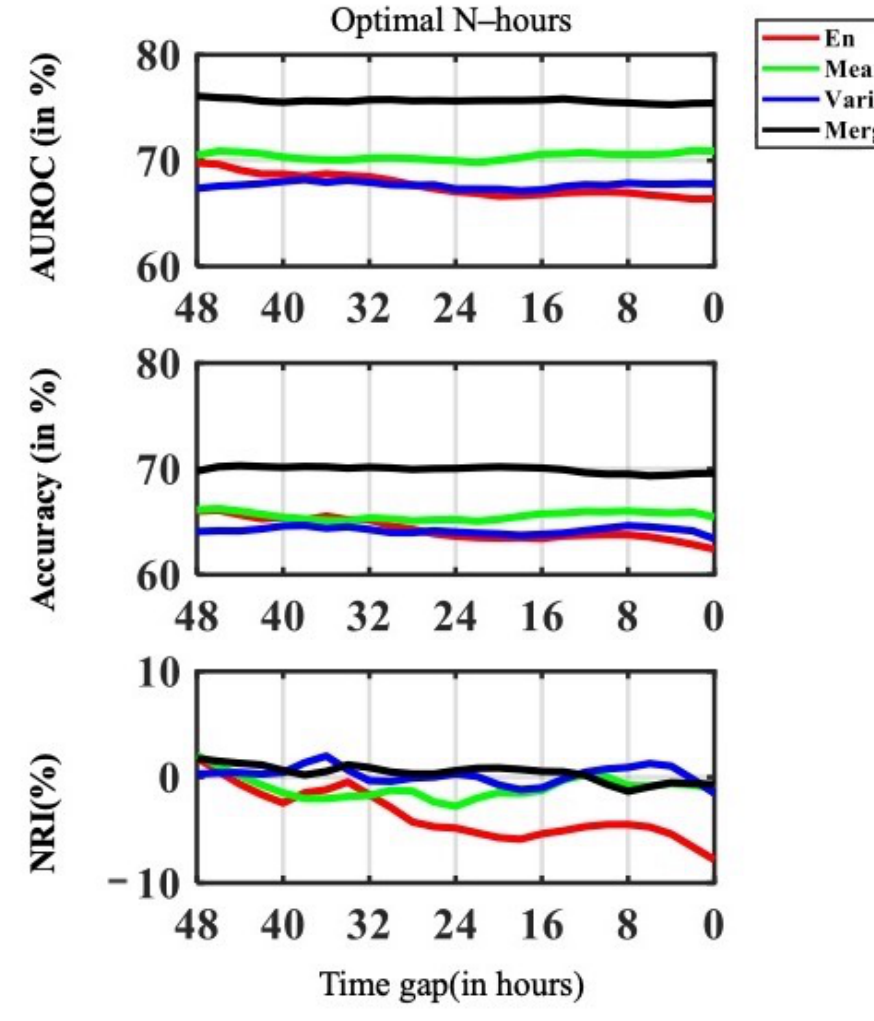
Figure 5. Visualization plot for time gap variance on AUROC, Accuracy and NRI